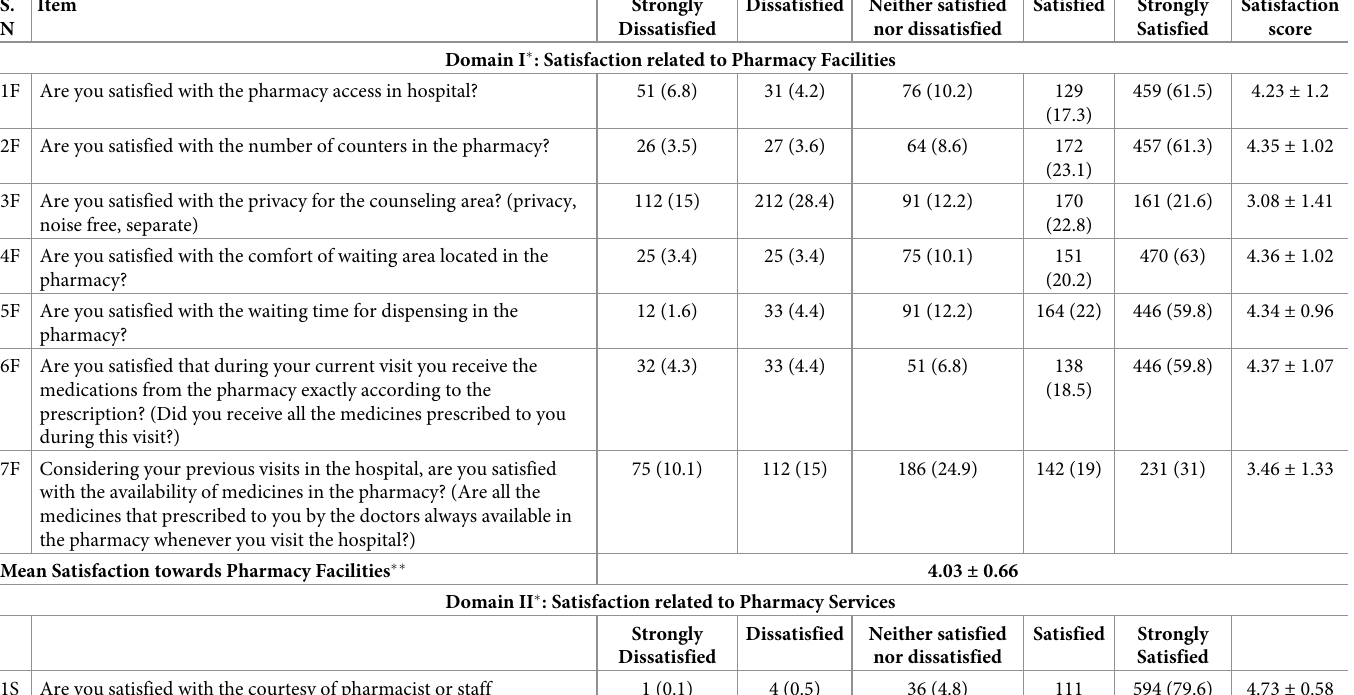
Table 2. The proportions and mean satisfaction scores of respondents towards pharmacy facilities and services. S. N